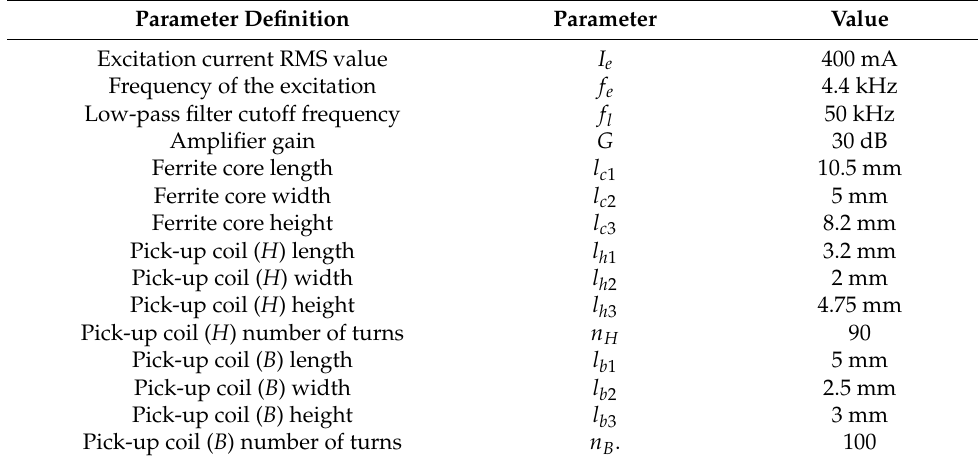
Table 1. Transducer parameters.